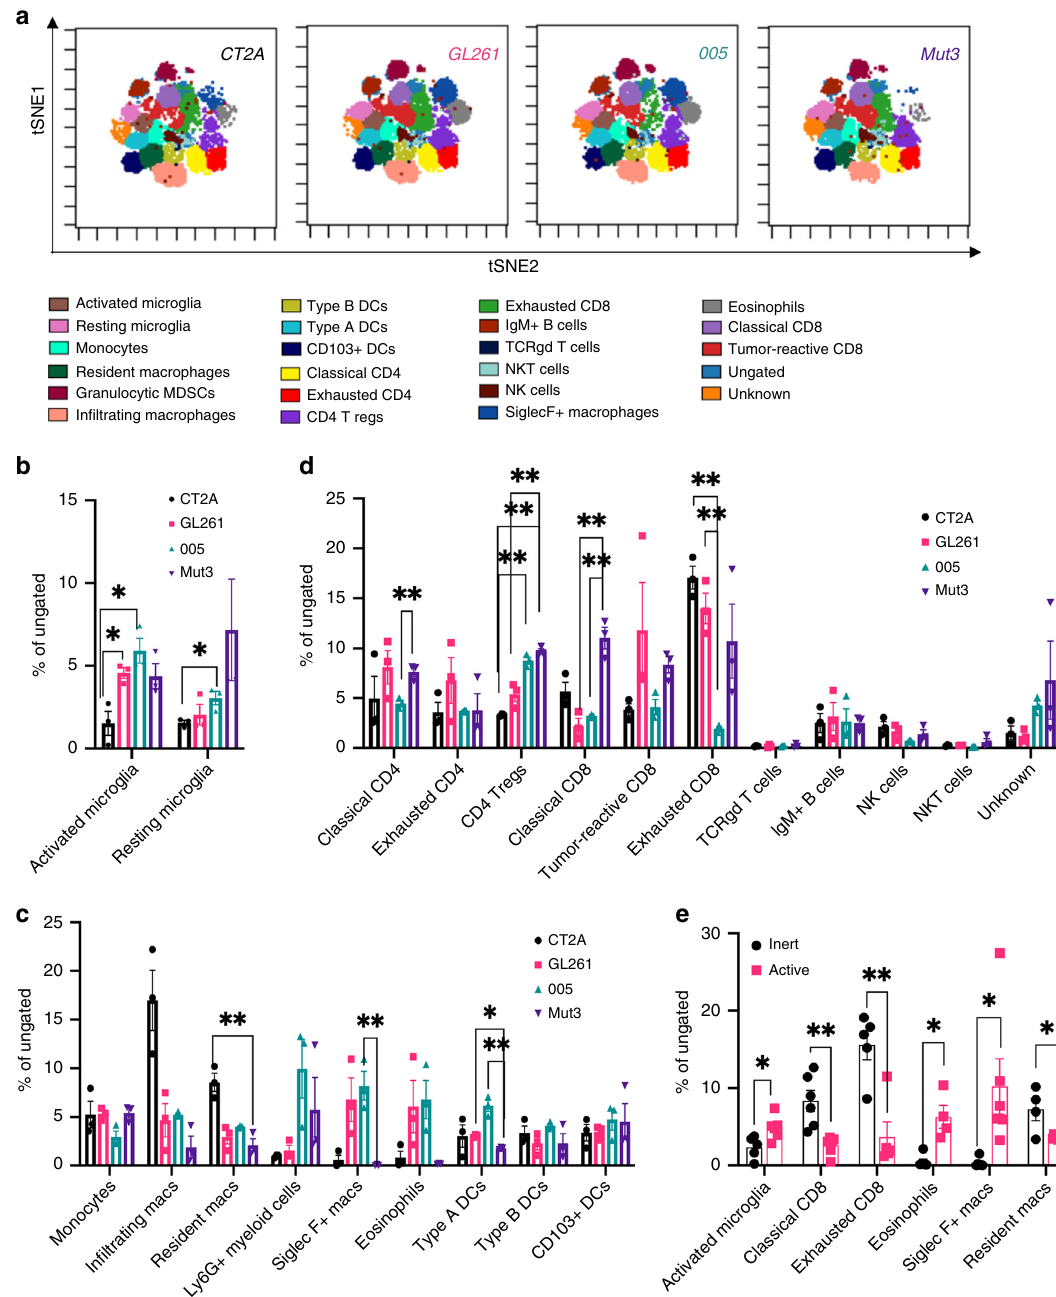
Fig. 3 FlowSOM analysis on immune cells in syngeneic mouse tumors. a Concatenated FlowSOM plot of different syngeneic tumor mouse models showing various populations de fi ned based on expression analysis. Major markers used for de fi ning clusters are activated microglia (CD45 low CD11b low CX3CR1 + MHCII + ), resting microglia (CD45 low CD11b low CX3CR1 + MHCII − ), monocytes (CD11b + F4/80 − CD64 + CX3CR1 + CD11c − ), resident